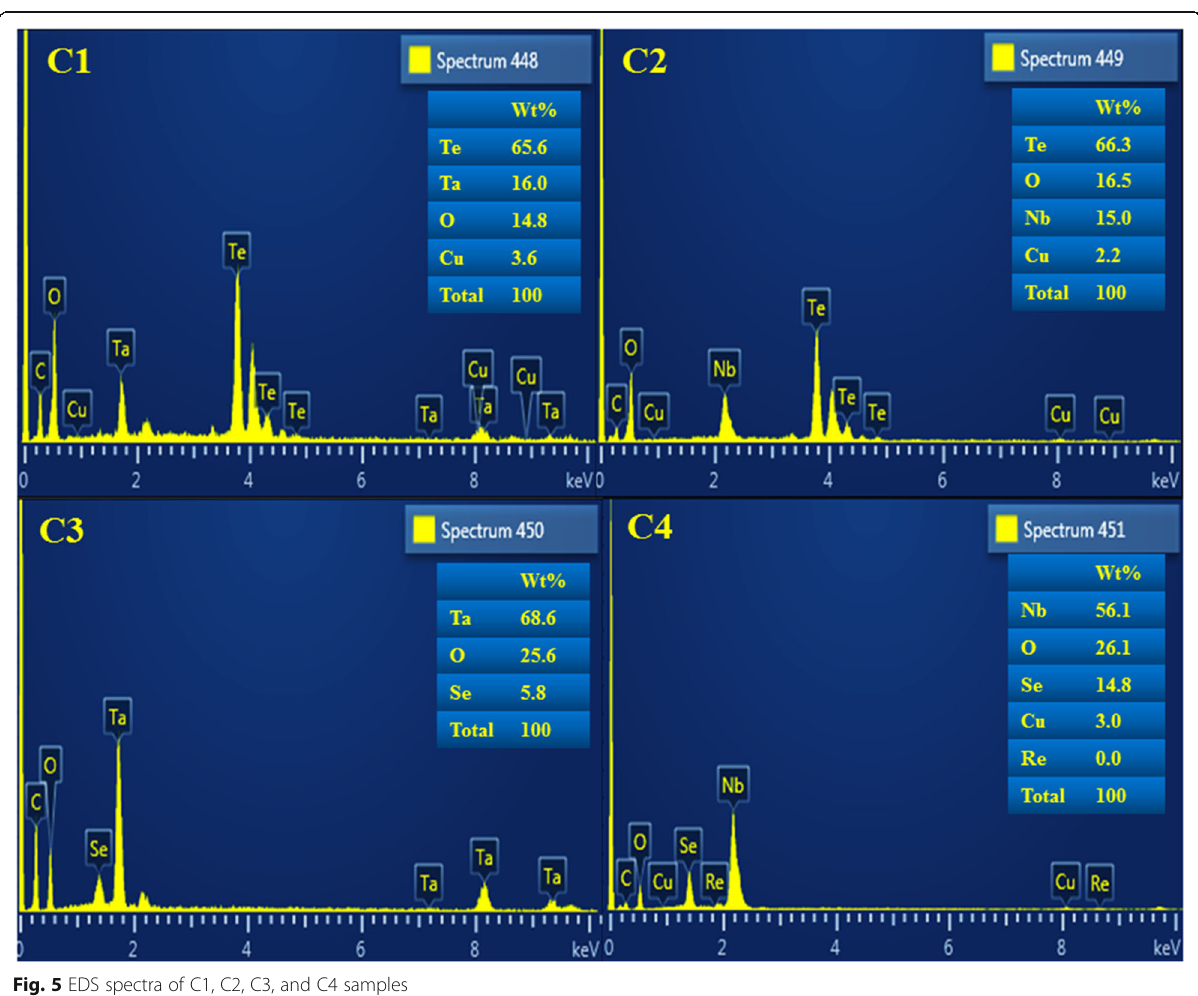
Fig. 5 EDS spectra of C1, C2, C3, and C4